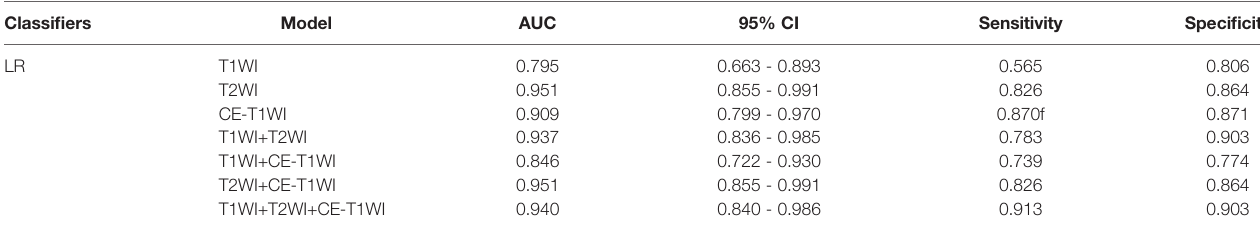
TABLE 6 | The ROC curve of different models of LR-classi fi er in the training cohort. Classi fi